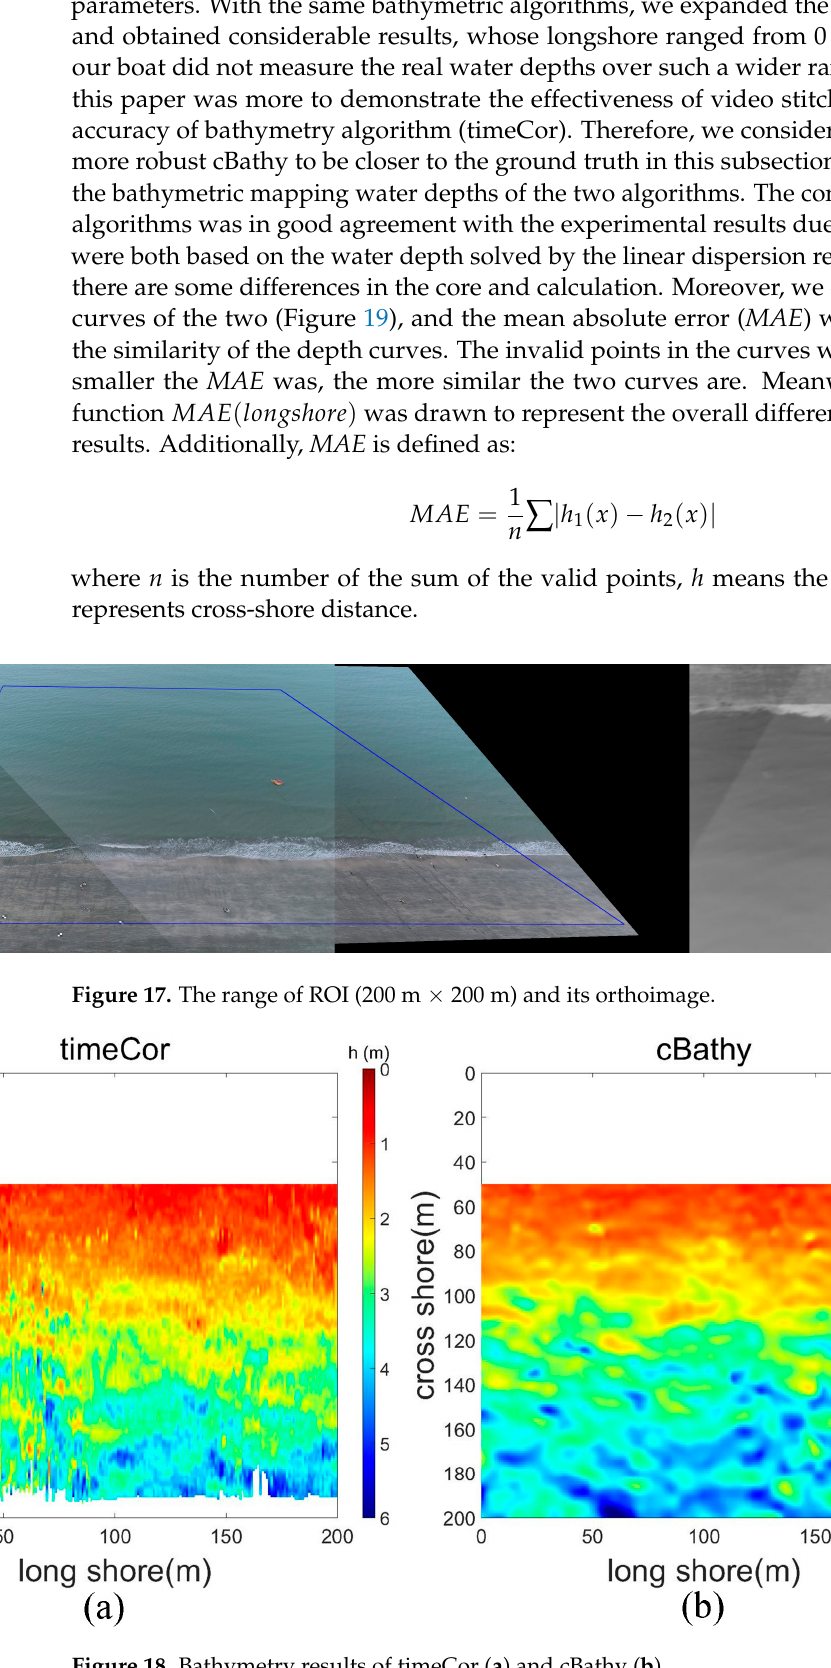
Figure 19. Comparison between timeCor and cBathy in longshore 75 m, 100 m, 125 m.